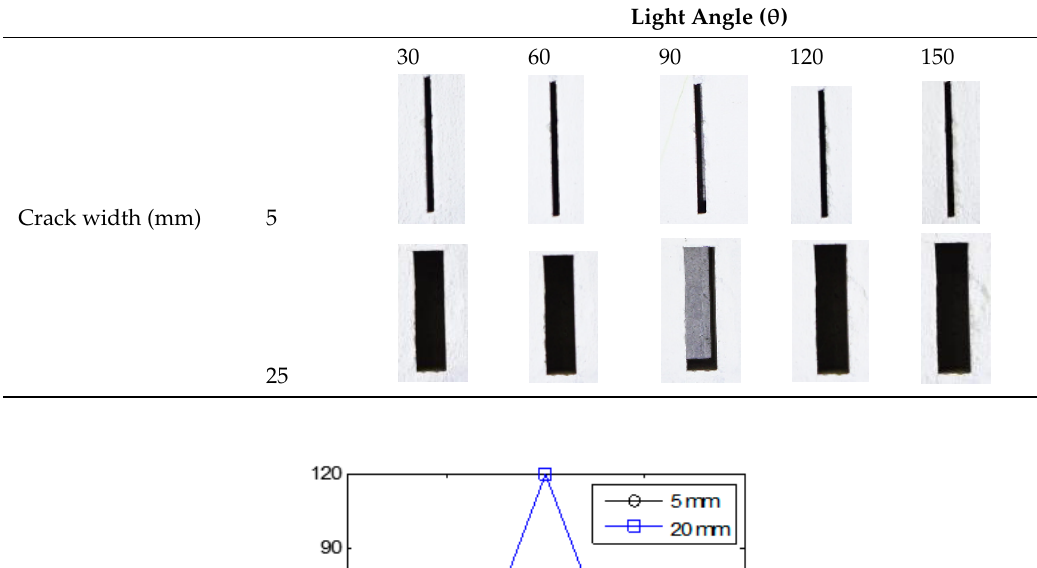
Figure B1. Test setup for analysis of lighting angle and intensity of cracks. Table B1. Changes in brightness in crack depending on light angle and crack width.